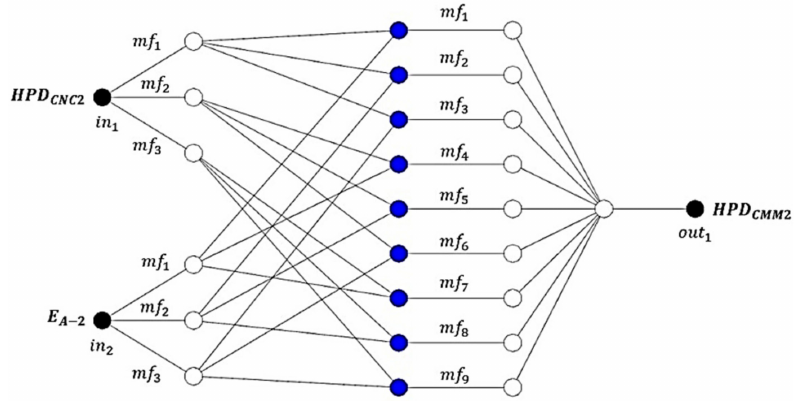
Figure 11. A network structure and flow chart of Equation